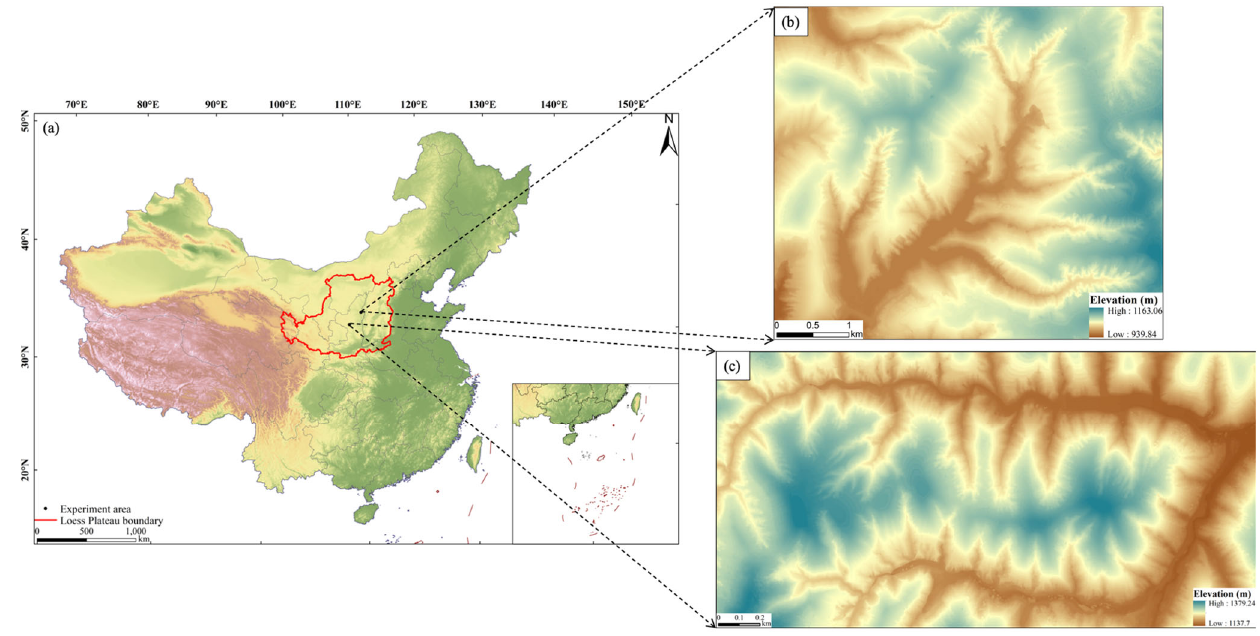
Figure 3. Location of the shoulder line in the Loess Plateau of China. ( a ) The Loess Plateau and the location of the study area in China; ( b ) DEM of the Suide study area; ( c ) DEM of the Yan’an study area.